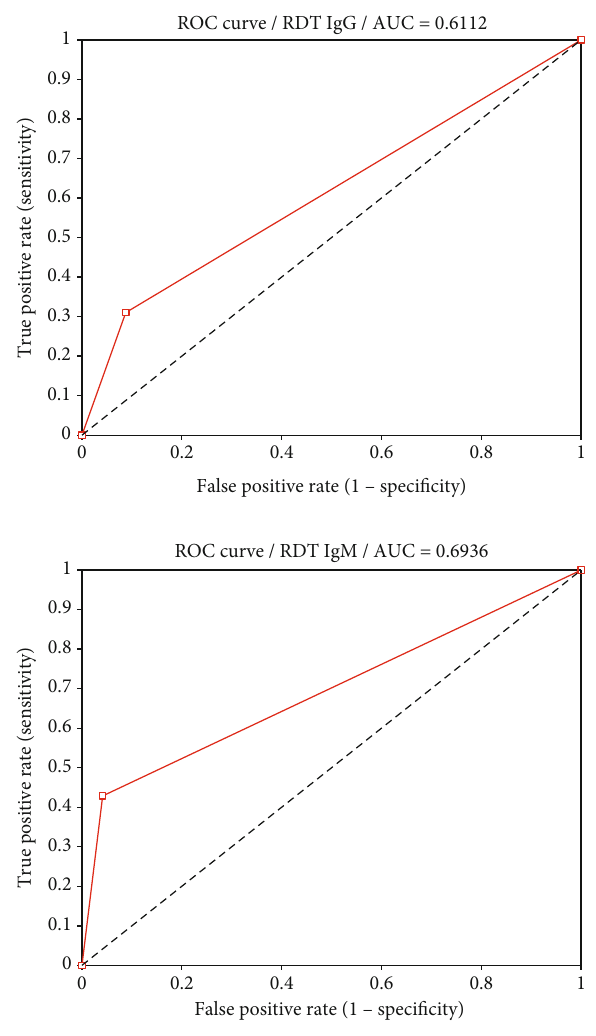
Figure 4: Receiver operating characteristic (ROC) curve showing the diagnostic